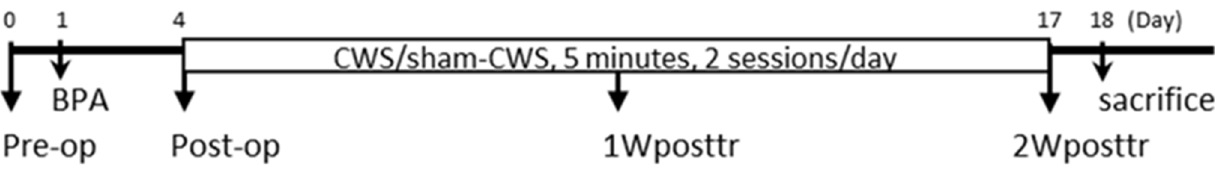
Figure 4. Overview of study design. Rats received brachial plexus avulsion surgery (Day 1) and then were treated with cold-water swimming (CWS) or sham CWS at 3 days after BPA surgery (Day 4) for 2 weeks (ended at Day 17). Assessments of functional recovery included both motor function test and sensory behavioral test performed before (Pre-op, Day 0), immediately after surgery (Post-op, Day 4), at first and second weeks after treatments (1Wposttr and 2Wposttr, Days 10 and 17). Animals were sacrificed for immunoassays (immunohistochemistry and morphological studies) at Day